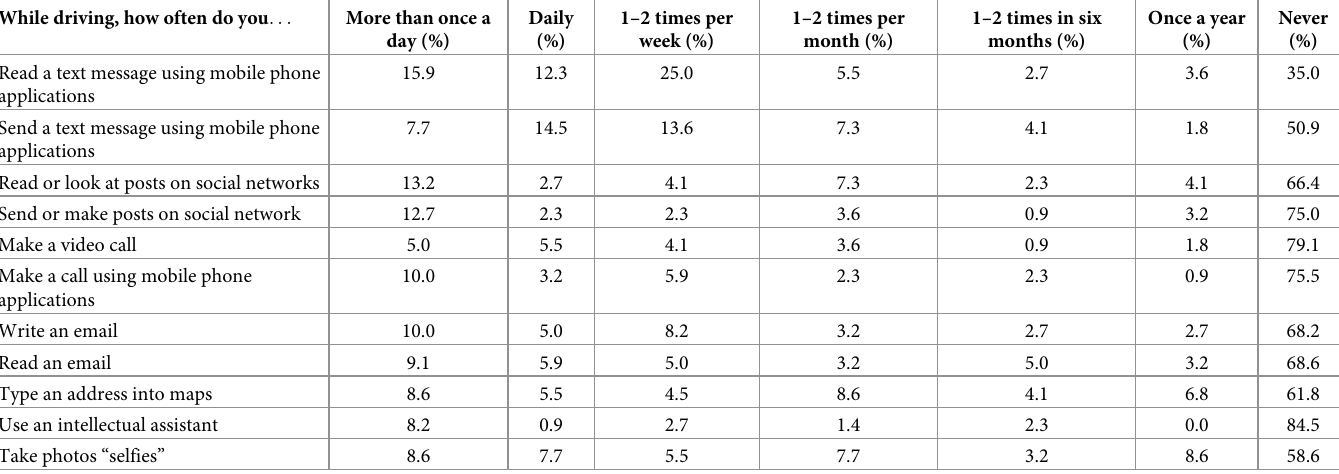
Table 1. Self-reported mobile phone applications usage while driving (N = 220). While driving, how often do you